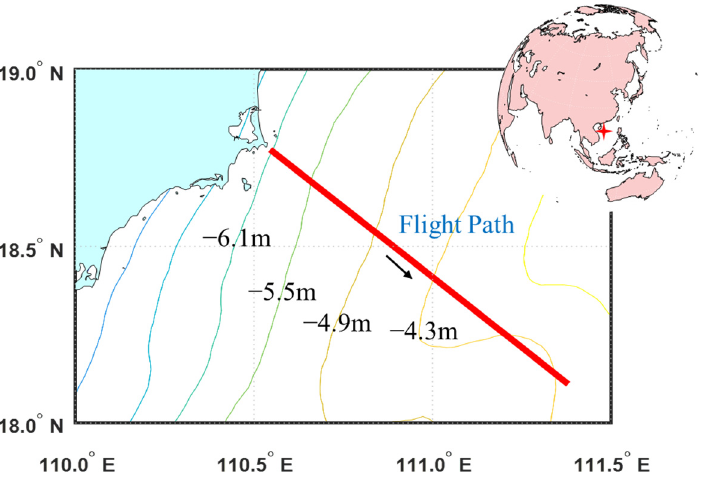
Figure 2. Map of the airborne experiment area. The red line represents the flight path, and the other colored curves represent the MSS contours.